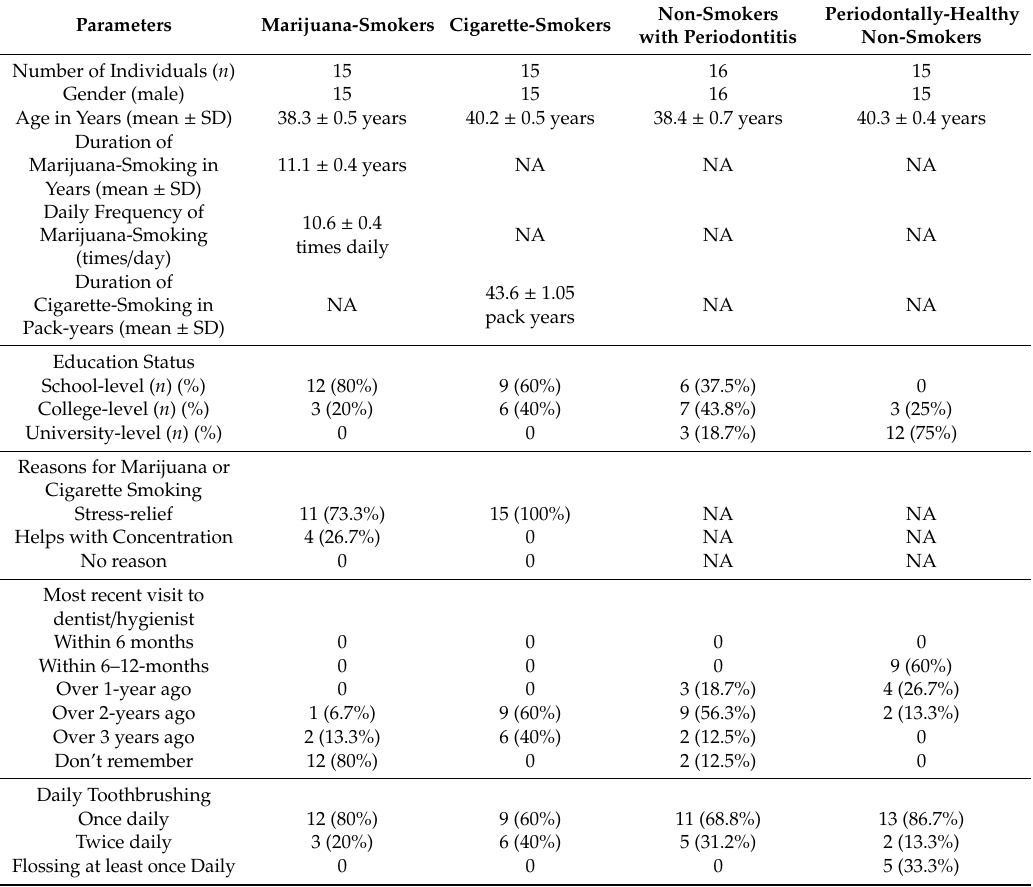
Table 1. Characteristics of the study cohort.